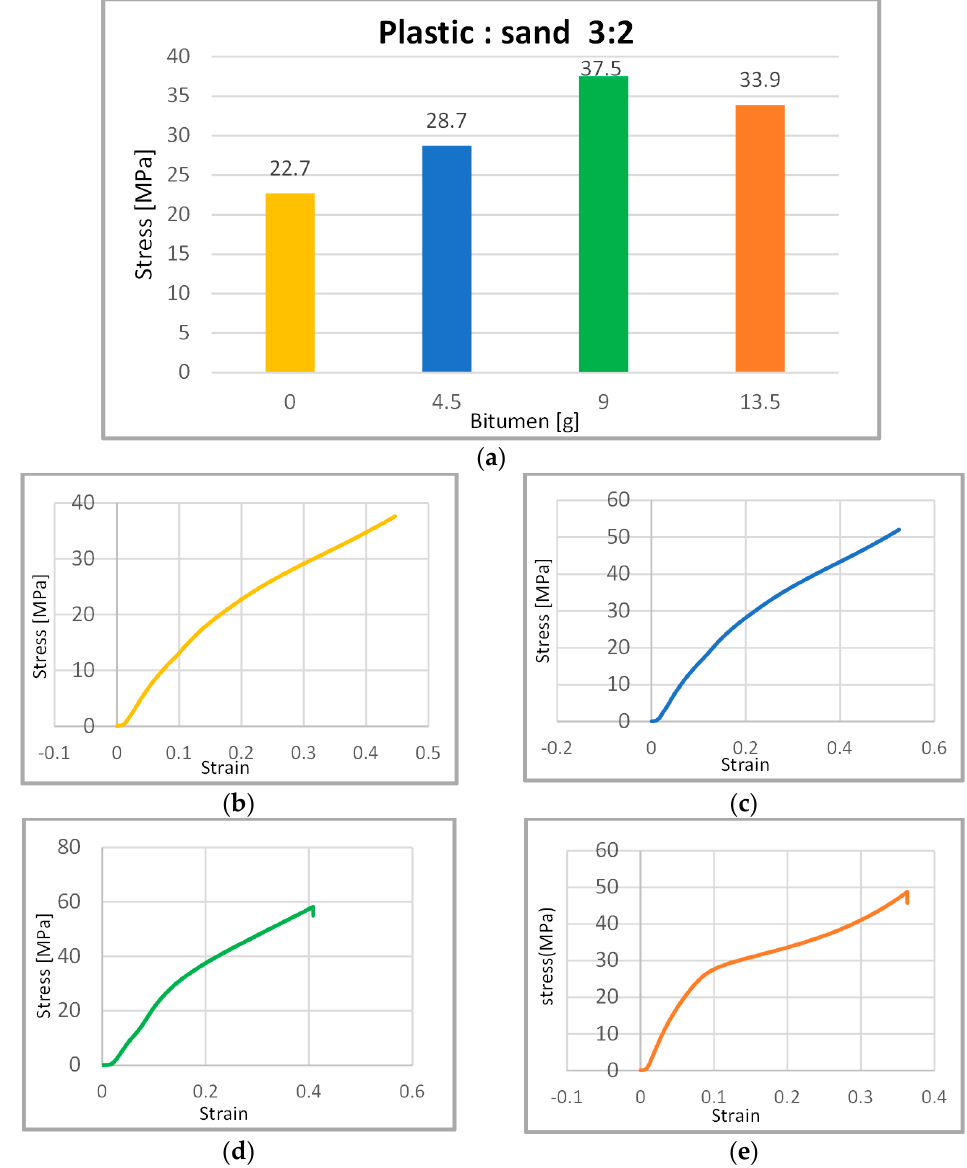
Figure 3. Results of brick sample 2. ( a ) Compression strength values of brick plastic to sand 3:2. ( b ) Stress–strain curve with 0 g bitumen. ( c ) Stress–strain curve with 4.5 g bitumen. ( d ) Stress–strain curve with 9 g bitumen. ( e ) Stress–strain curve with 13.5 g bitumen.